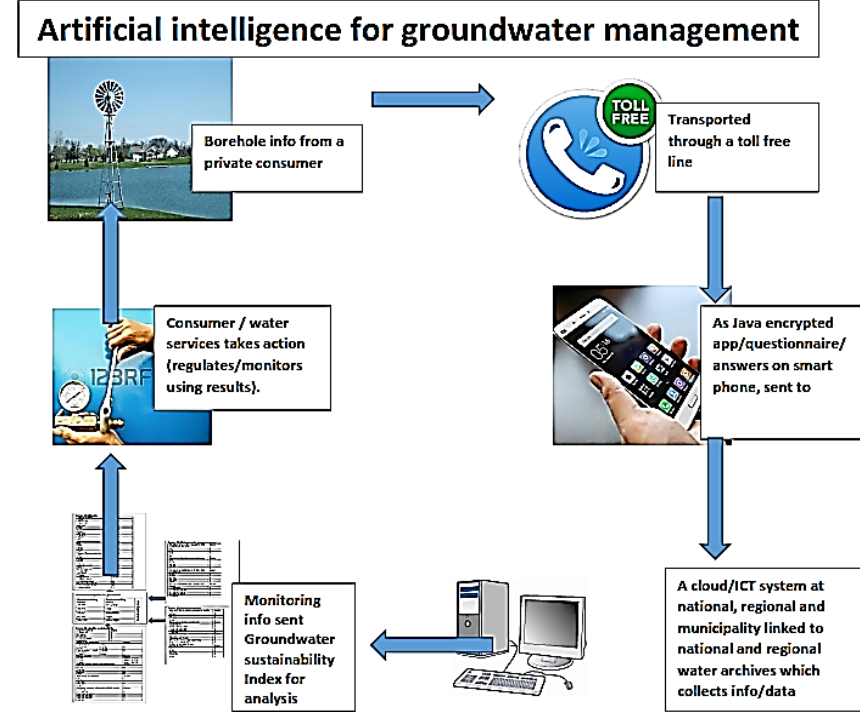
Figure 1. Proposed App architecture.